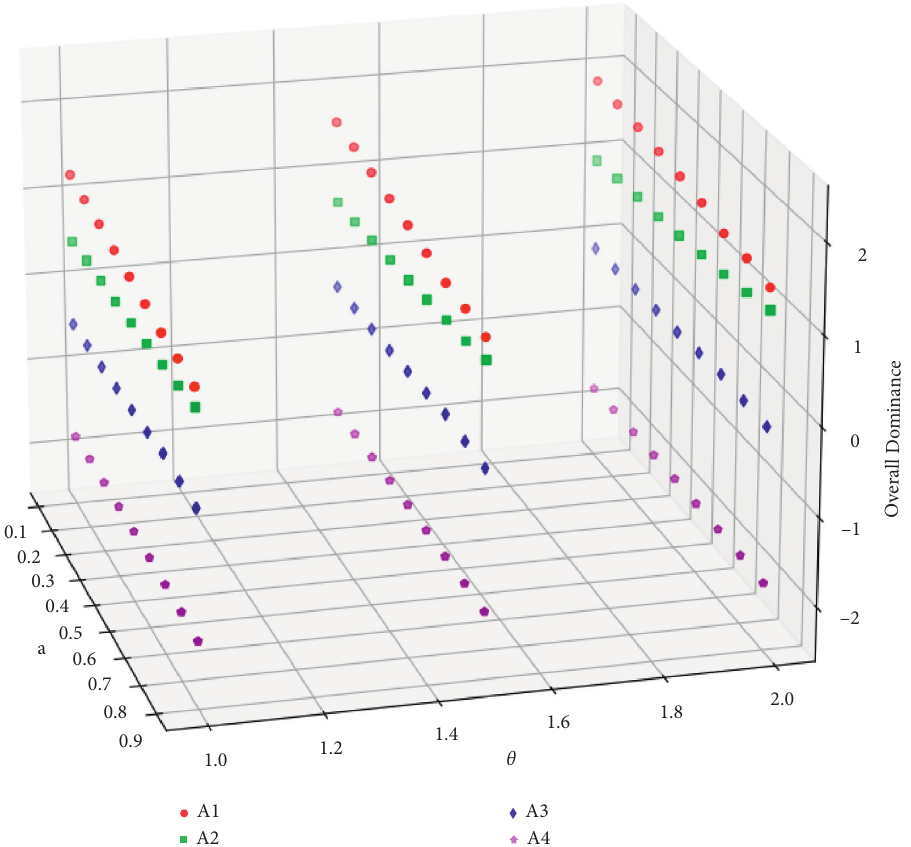
Figure 7: The pictorial expressions of the dominance values with different values of α and θ in case of q �